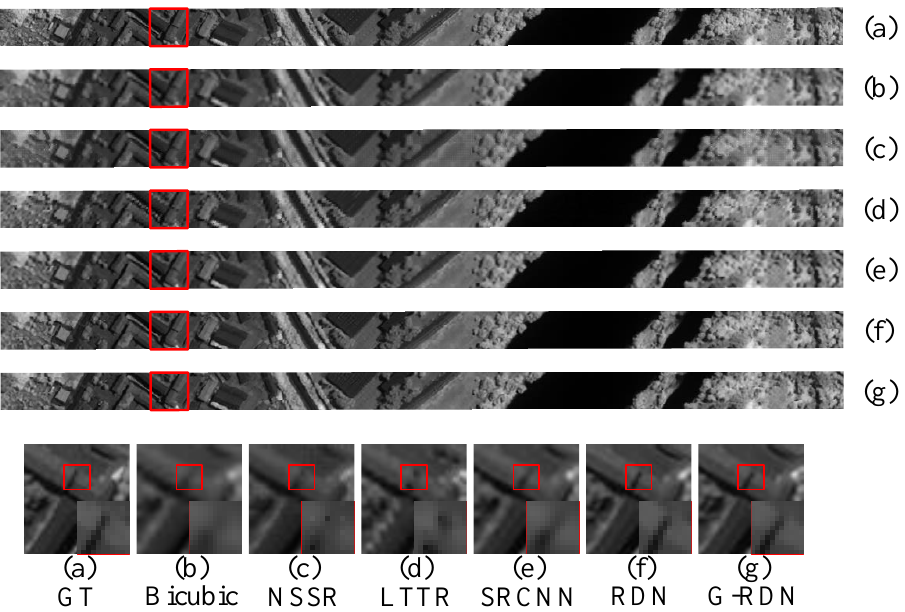
Figure 10. Visual exhibition of the reconstructed Pavia Center at the scaling factor of 3. In addition, to present the spectral distortion of the reconstructed image, we randomly selected one pixel from the scene and drew the corresponding spectral curves reconstructed by different methods, as shown in Figure 12. It can be clearly seen that the RDN and the G-RDN methods were obviously superior to the other methods in the spectral preservation. When compared with the RDN, the spectral curve achieved by the proposed G-RDN was closer to that of the ground truth, resulting in less spectral